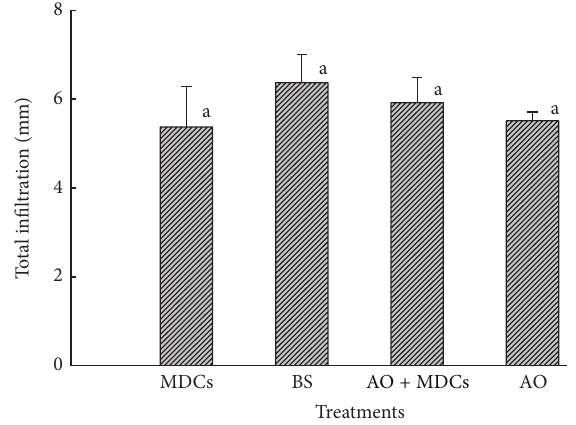
Figure 4: Total infiltration of the moss-dominated crusts plots (MDCs), bare sand plots (BS), Artemisia ordosica plots (AO), and Artemisia ordosica combined with moss-dominated crusts plots (AO + MDCs) after an 8.3 mm rain event. Note: different letters indicate significant differences at a 5% probability